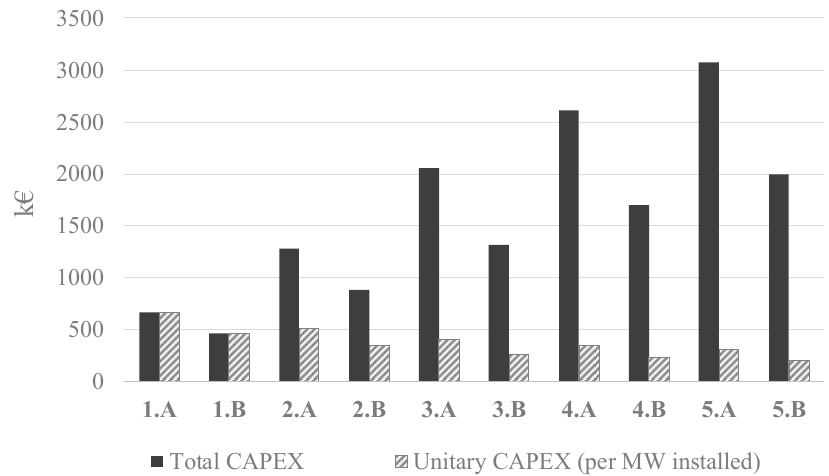
Figure 10. Maximum total CAPEX (for total installed power of each case) and maximum unitary CAPEX per MW installed.